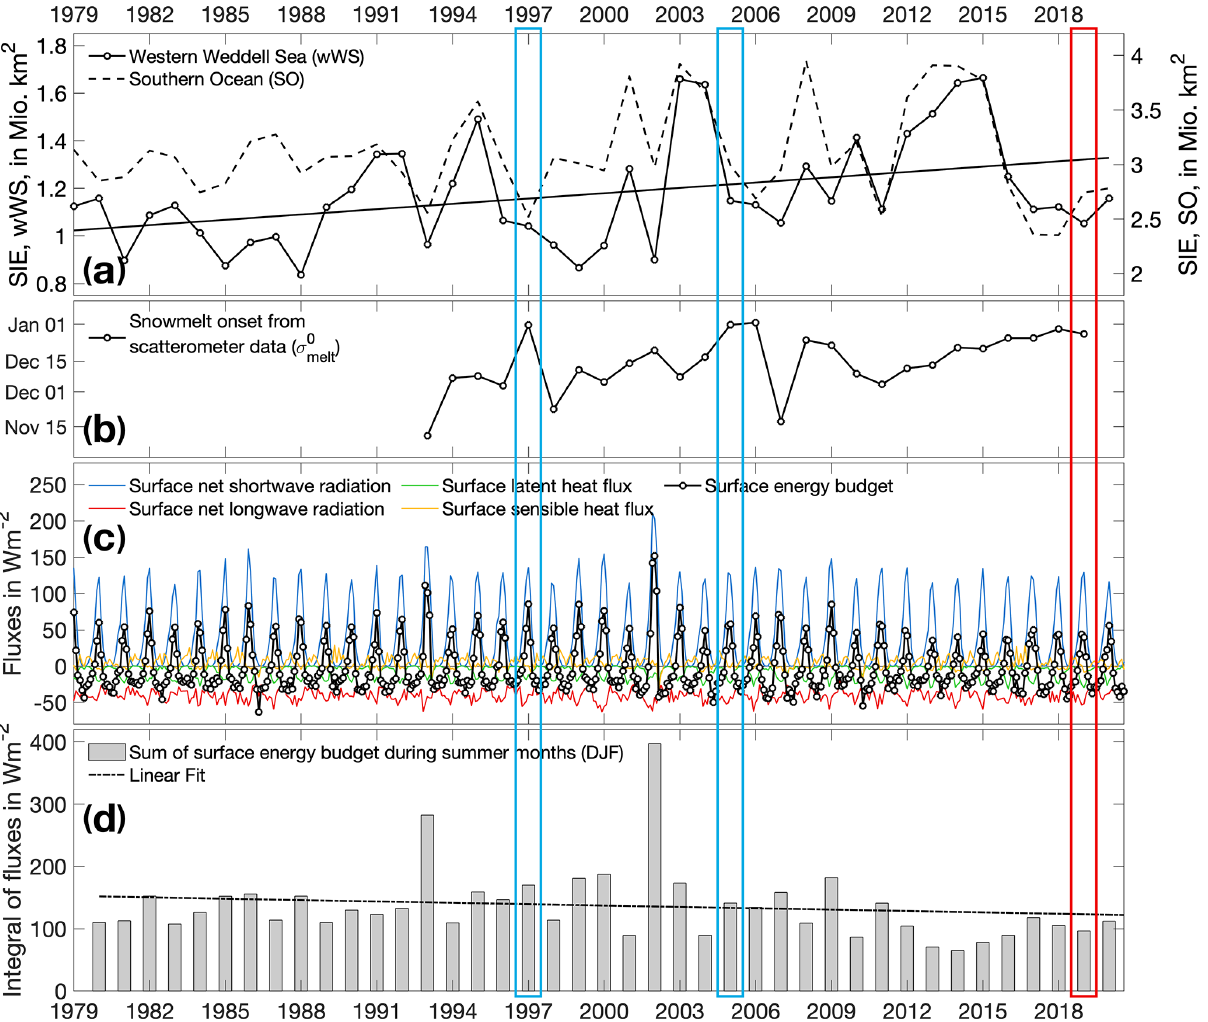
Figure 5. Time series of ice extent, melt onset, and surface energy balance in the northwestern Weddell Sea (Sect. 2.4). (a) Sea ice extent (SIE) in the western Weddell Sea west of 30 ◦ W (wWS, solid line), and in the whole Southern Ocean (SO, dashed line), for February 1979– 2020. Line shows linear fit to Weddell Sea data with a slope of + 7000km 2 yr − 1 . (b) Snowmelt onset north of 69 ◦ S from scatterometer data. (c) Surface energy budget north of 69 ◦ S (black line) and its individual components (colored lines). (d) Annual total summer surface energy budget (sum from December to February). The dashed line shows the linear fit with a slope of − 0 . 7Wm − 2 yr − 1 . The red box highlights the year of the WedIce expedition, 2019; blue boxes show years of field observations in 1997 and 2004/05 (ISPOL). Note that the year markers on the x axis represent 1 January of the respective